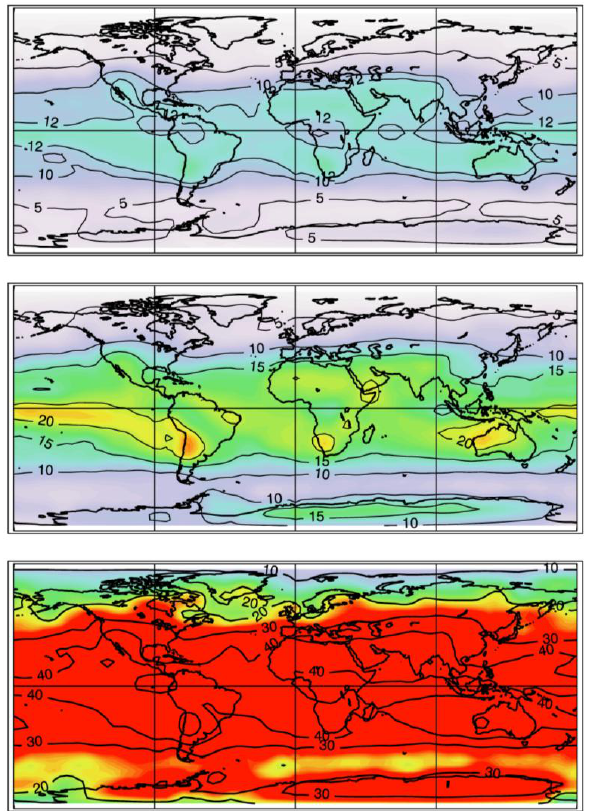
Fig. 11. Maximal UV indices calculated in the years 2010, 2050 and 2090 in noMPA case. The colour scale was limited to a UV Index of 25 to reflect the current (2010) maximum UV levels observed in the South American Andes. The contour lines have no upper limit and extend from UV index 0 to 40 in steps of 10.